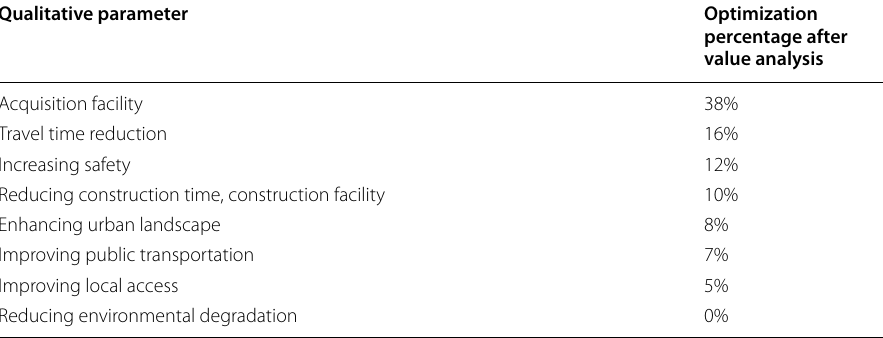
Table 9 Construction and total costs of the projects Qualitative parameter Optimization